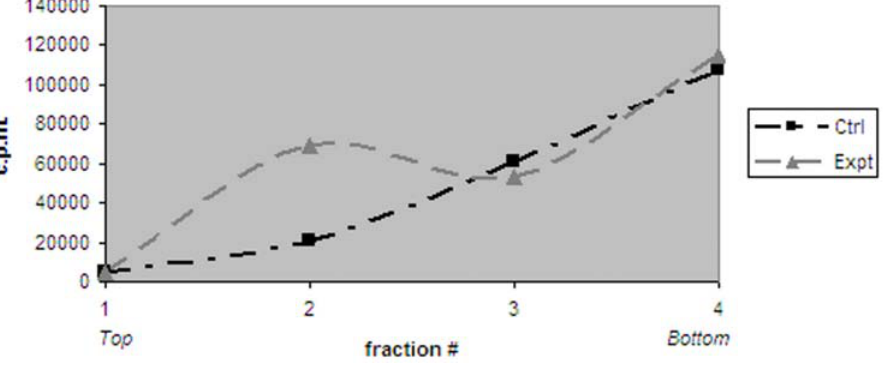
Figure 3. MRBL-borne modified EGF receptors show binding specificity for EGF. Binding of [ 125 I]EGF to MRBLs as assessed by liquid scintillation counting. Ctrl, MRBLs pre-incubated with an excess of unlabeled EGF before incubation with [ 125 I]EGF. Expt, MRBLs not pre-incubated with an excess of unlabeled EGF before incubation with [ 125 I]EGF.